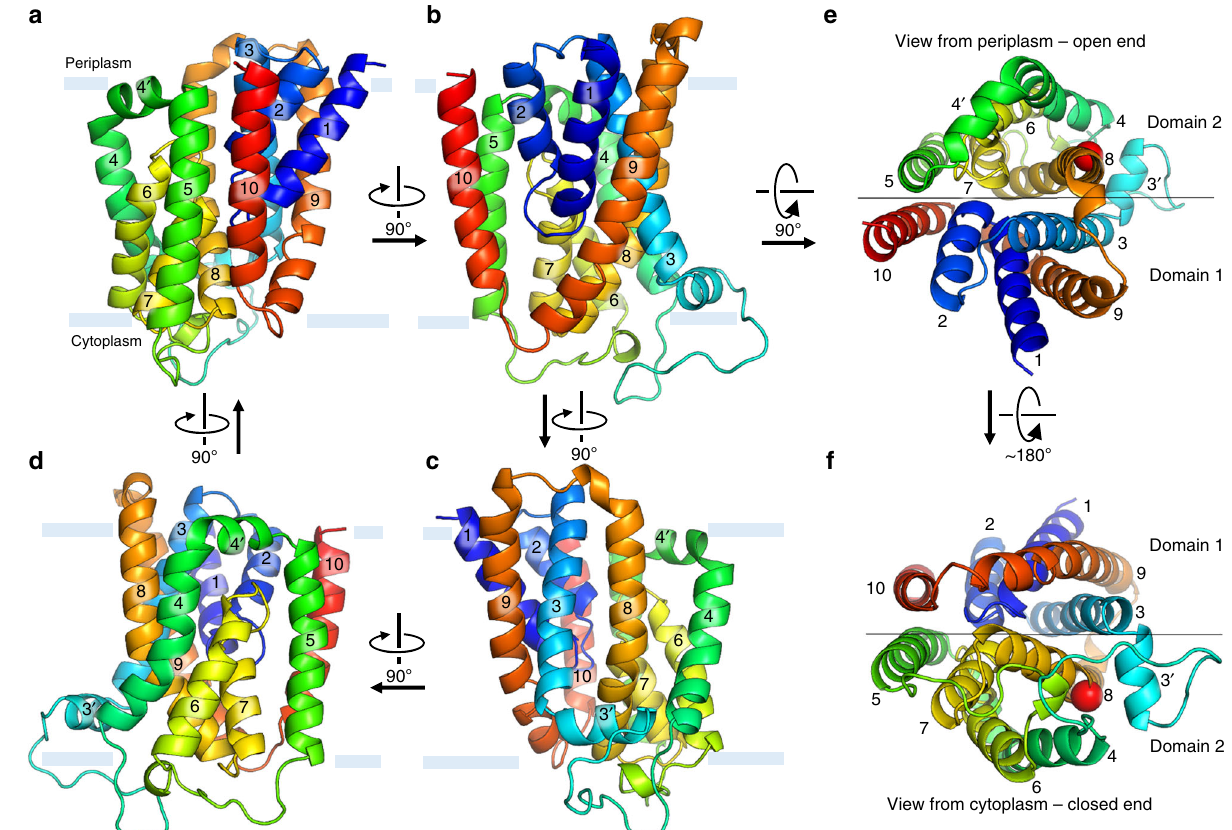
Fig. 4 Overall architecture of BacA from E. coli . a – d Views of BacA from within the membrane rotated by ~90 degrees about an axis normal to the membrane plane and passing through the core of the protein. e , f Views of BacA from the periplasm/open and cytoplasm/closed end, respectively. The thin black line in e , f marks the location of the approximate C 2 axis of pseudosymmetry and separates BacA into two domains. Pro202 at the kink in H8 is shown as a red